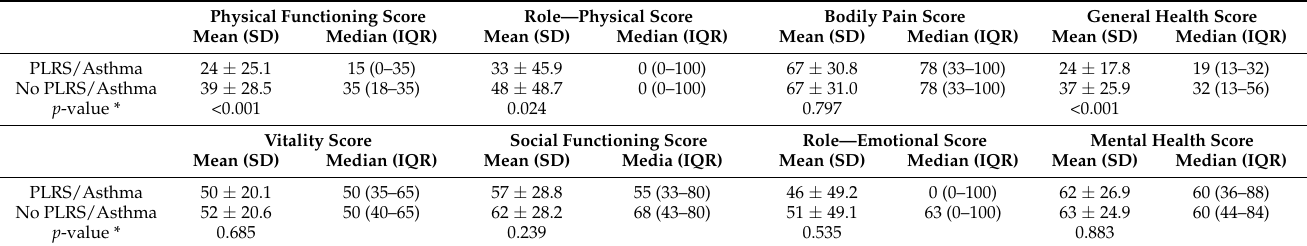
Table 2. Health-related quality of life SF-36 scale scores of Macassar residents stratified according to the presence of persistent lower respiratory symptoms or asthma 6 years after the fire incident ( n = 246).